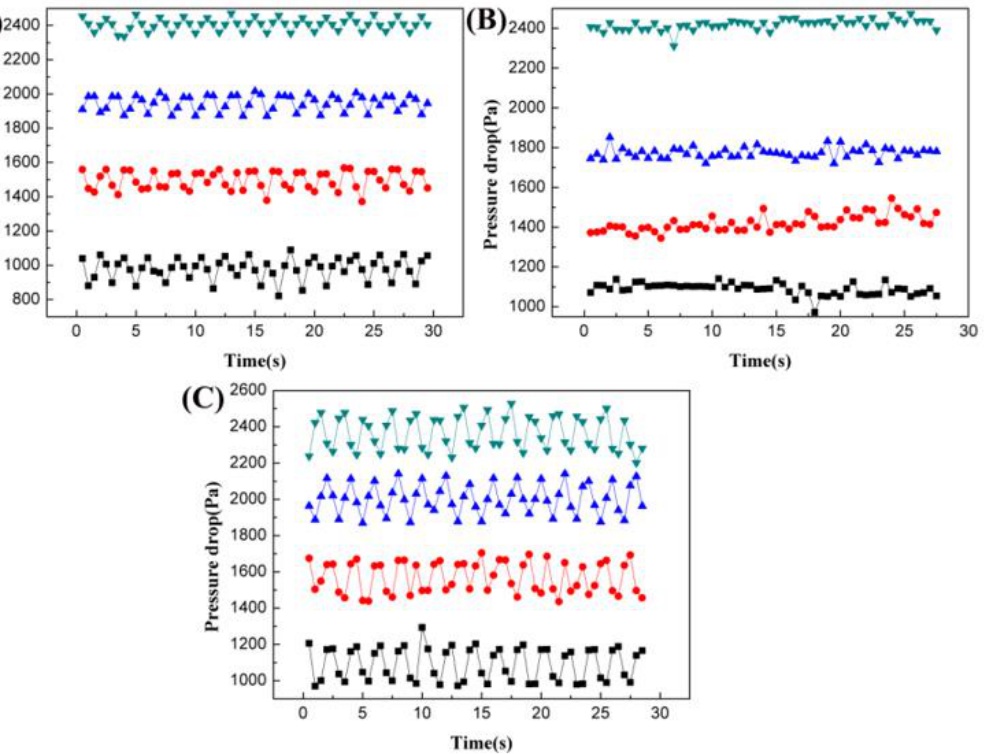
Figure 4. The time evolution of the pressure drop at different bed heights and superficial velocities when the particle size is 0.7 ± 0.1 mm and particle density is 1700 kg/m 3 : ( A ) ν s = 0.0125 m/s; ( B ) ν s = 0.0167 m/s; ( C ) ν s = 0.0208 m/s.